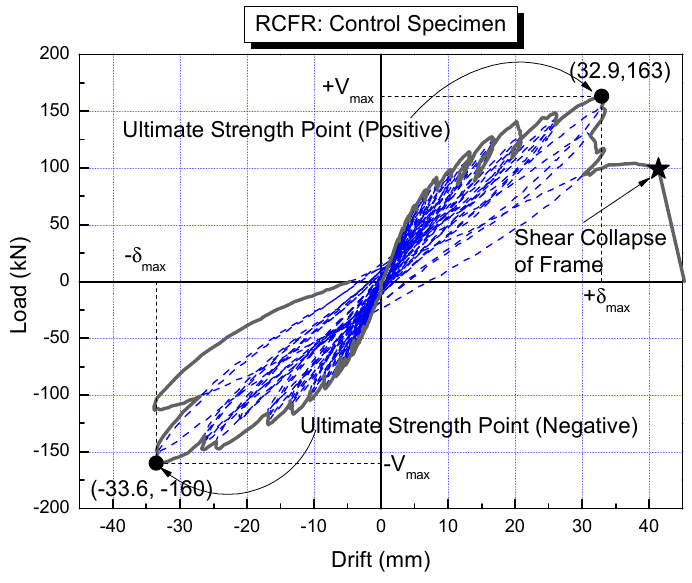
Figure 7. Load–drift relations for the RCFR sample.